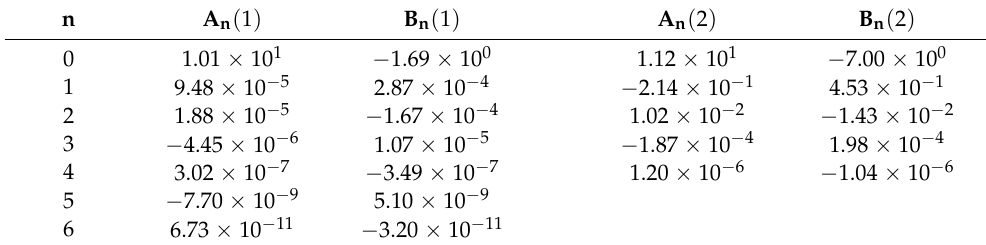
Table A9. Coefficients of the H 2 O-LiI saturated pressure equation.